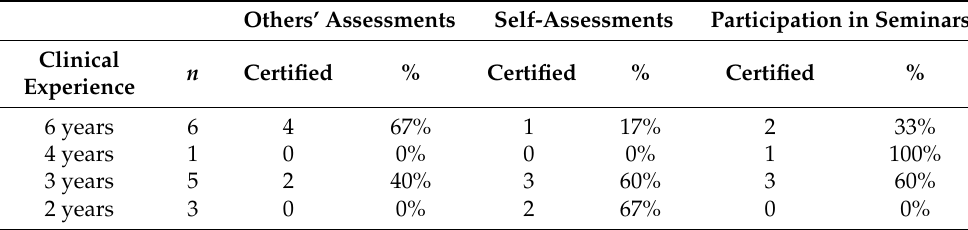
Table 3. The results of the UNNAN ladder certification